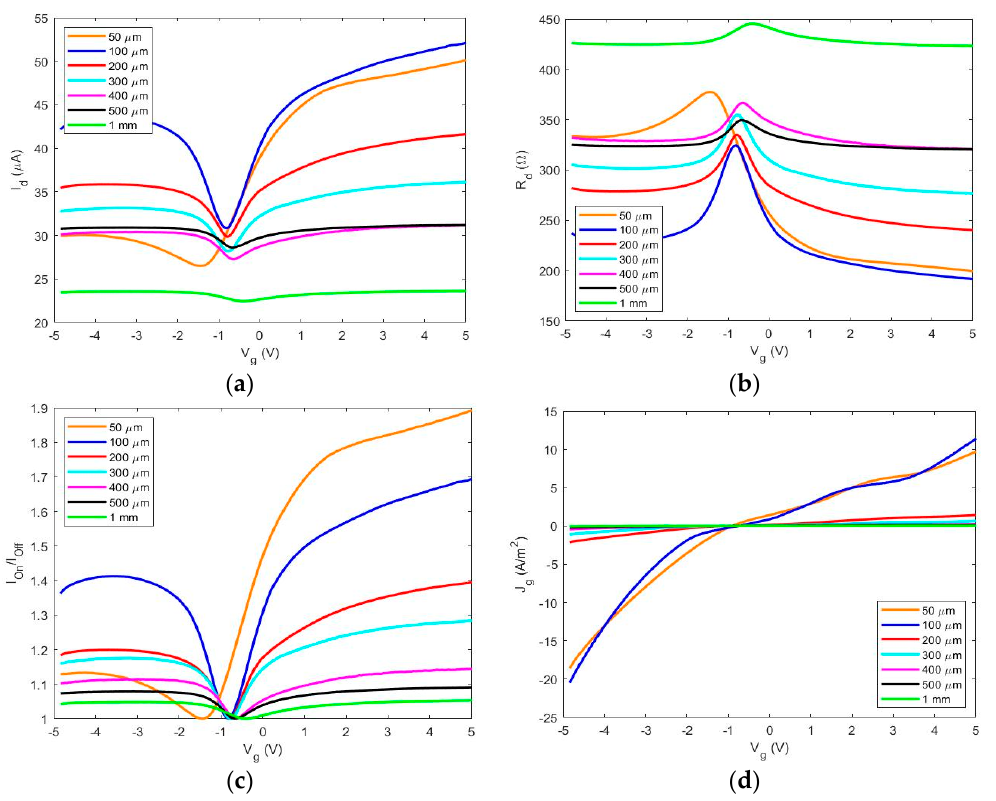
Figure 5. Graphene charge transport characteristics for several graphene field-effect transistors with varying channel-length: ( a , b ) illustrates the drain current ( I d ) and drain resistance ( R d ) as a function of top-gate voltage ( V g ); ( c ) details the on:off ratio ( I on / I off ) and ( d ) illustrates the gate-leakage current density.